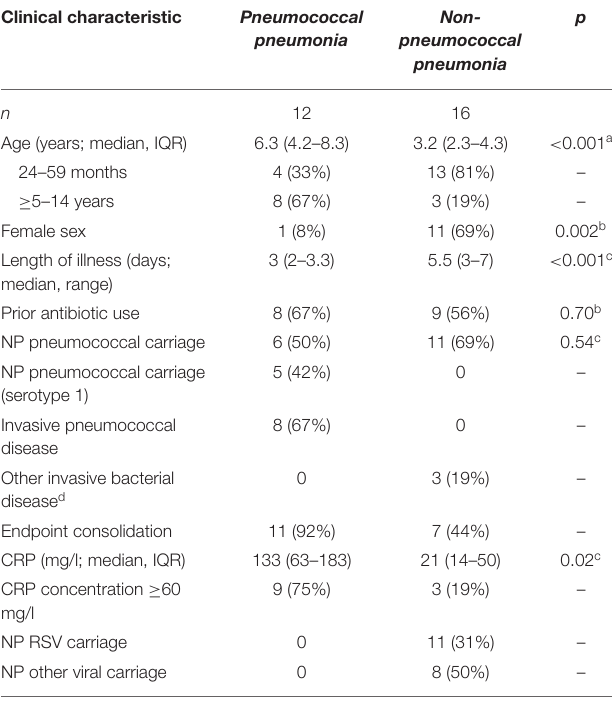
TABLE 3 | Acute IgG ALS to pneumococcal proteins by children with pneumococcal pneumonia and non-pneumococcal pneumonia in children ≥ 2 years of age enrolled in the